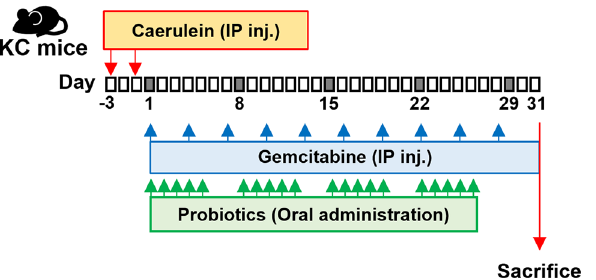
Figure 1. Schematic representation showing the time course for developing a mouse model of pancreatic